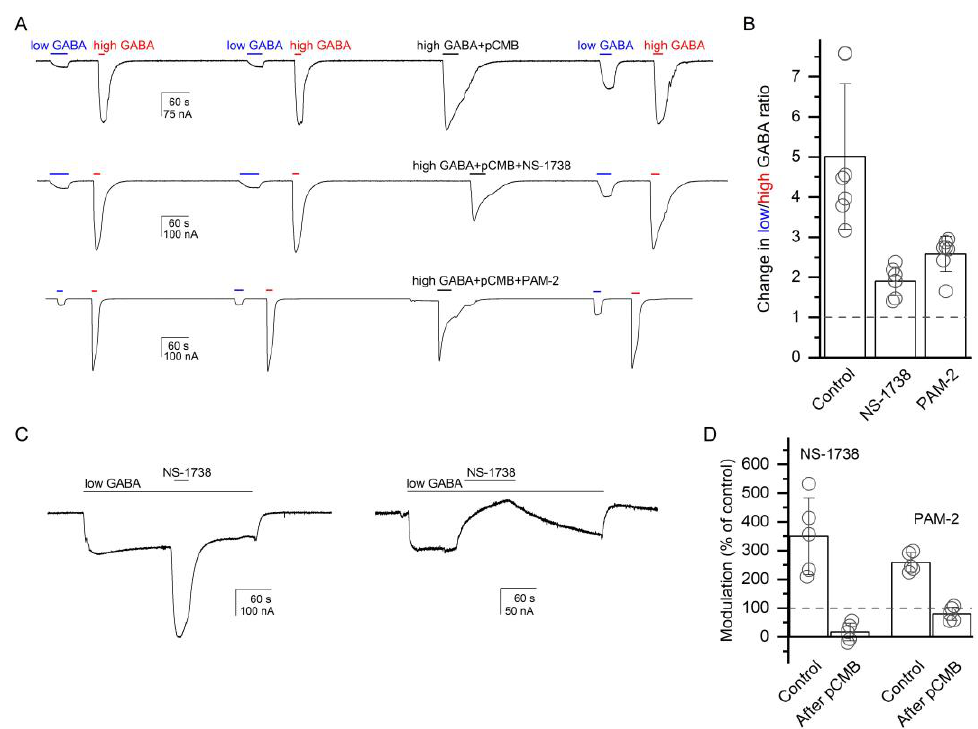
Figure 5. Chemical modification of the α1(L231C) residue at the β+/α− interface modifies receptor activation by GABA and modulation by α7-PAMs. ( A ) Exposure to pCMB (30 s, 25 μM) increases the ratio of responses to low (3 μM) and high (1 mM) GABA in the α1(L231C)β2γ2L receptor. The pCMB-induced increase in the low-to-high GABA ratio is reduced when pCMB is co-applied with 50 μM NS-1738 (middle trace) or PAM-2 (bottom trace). The data are summarized in the column graph ( B ). We infer that chemical modification of the α1(L231C) residue modifies responses to the transmitter and that co-application of an α7-PAM protects against labeling with pCMB. ( C ) Exposure to 50 μM NS-1738 potentiates the response to 4 μM GABA (P A = 0.03) in the α1(L231C)β2γ2L receptor (left trace). NS-1738 inhibits the response to 0.05 μM GABA (P A = 0.01) following a 30 s exposure to 25 μM pCMB. The traces are from different oocytes. Drug application durations are given with horizontal lines. The data for NS-1738 and PAM-2 are summarized in the column graph ( D ). We infer that pCMB-labeling of the α1(L231C) residue abolishes receptor potentiation by α7- PAMs.